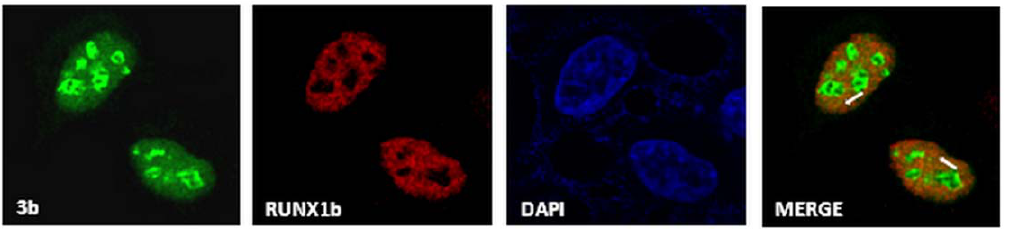
Figure 2. 3b partially co-localizes with RUNX1b in the nucleus. Cellular distribution of 3b and RUNX1b proteins were visualized by subjecting Flag-RUNX1b and HA-3b transfected HEK293 cells to immunofluorescence assay. 3b was visualized using primary a –HA and alexa-488 conjugated secondary antibody. RUNX1b was visualized using primary a –RUNX1 and alexa-594 conjugated secondary antibody. Nuclei were visualized by DAPI (4 9 6-diamidino-2-phenylindole) staining. Arrows indicate extra nucleolar nucleus area of partial co-localization.